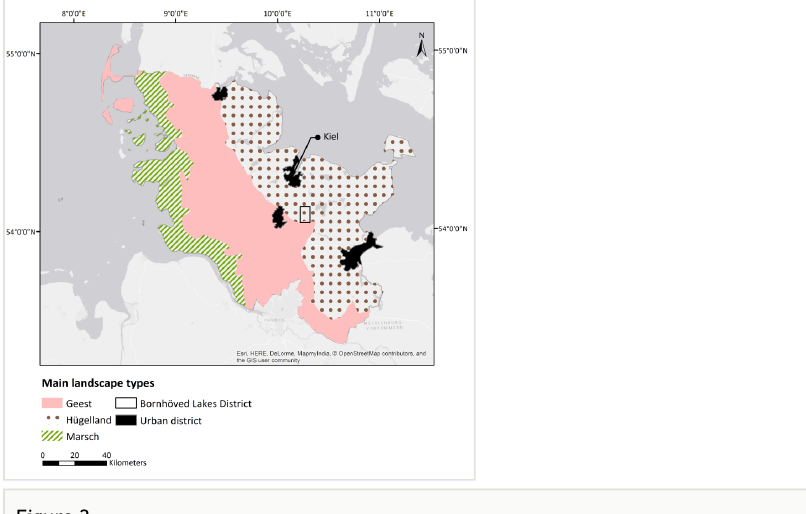
Figure 2. Schleswig-Holstein study area, showing the di ff erentiation between main landscape types (based on data from LLUR 2017 ). *6